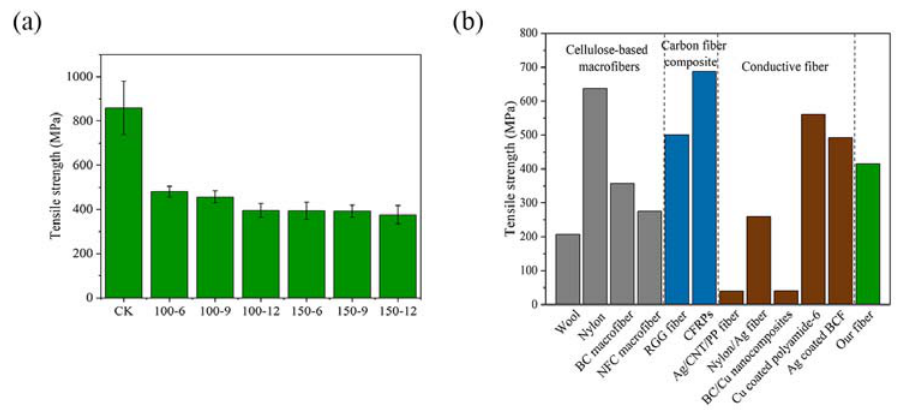
Figure 3. ( a ) The tensile mechanical properties of the bamboo fiber bundle and samples after mag- netron sputtering. ( b ) Comparison of tensile strength between conductive bamboo fiber bundle and other fiber